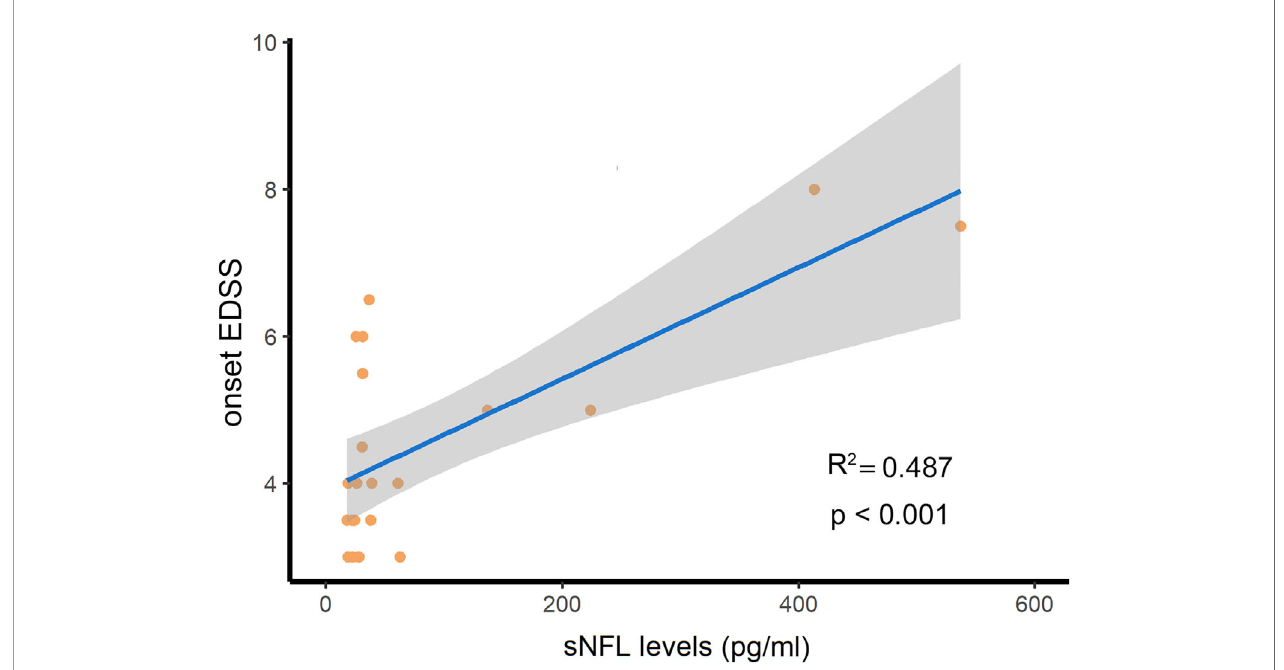
FIGURE 5 | The serum NFL (sNFL) levels were positively related with the expanded disability status scale (EDSS) scores at attack in NMOSD patients. R2, determination coef fi